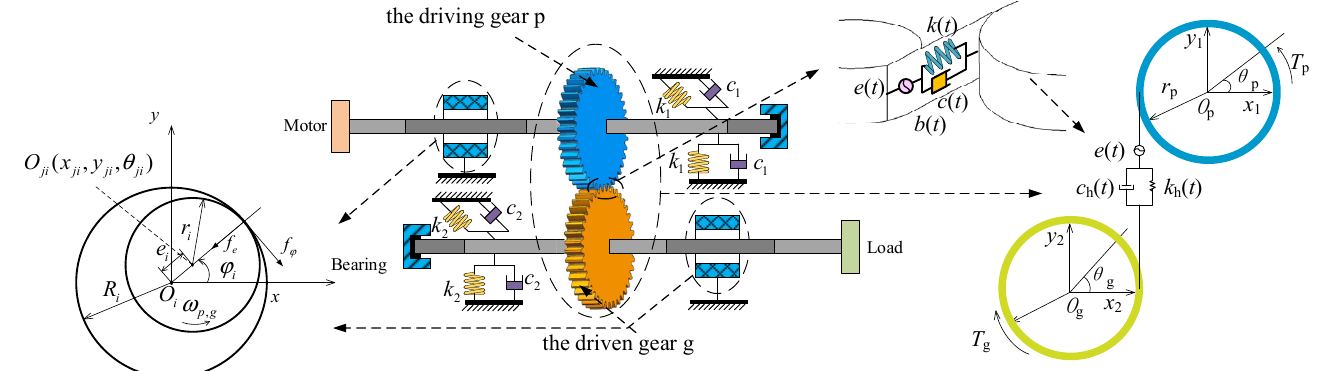
Figure 1. The lumped mass model of a gear-bearing system.